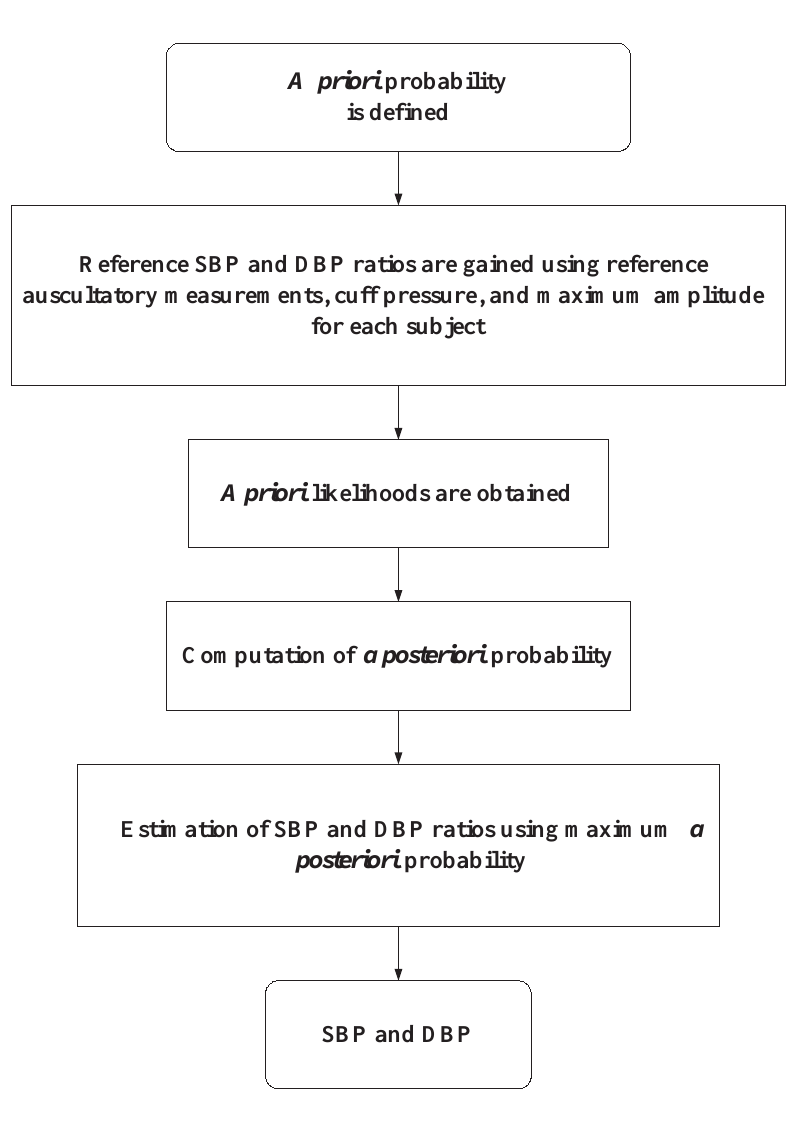
Figure 4. The estimation of SBP and DBP is used to estimate the SBP and DBP ratio based on the Bayesian